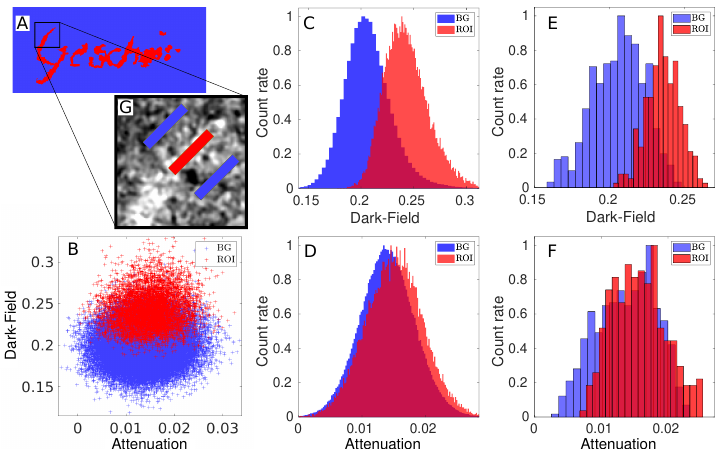
Figure 3. Quantitative evaluation for the thorn ink sample. ( A ) Separation mask of the region of interest (ROI) marked in red and the background region marked in blue. ( B ) Scatter plot of the dark-field values versus the attenuation for the ROI (red) and the background (blue). ( C ) Histogram of the ROI dark-field values (red) and the background (blue), showing a separation of the two peaks. ( D ) Histogram of the attenuation values from the same regions in the same colour code. ( E ) Dark-field histogram for the two blue background markers and the red ROI marker on the letter G , as can be seen in the zoom-in. ( F ) Attenuation histogram for the three markers. ( G ) Zoom-in showing the red marker on and two blue markers next to the letter G